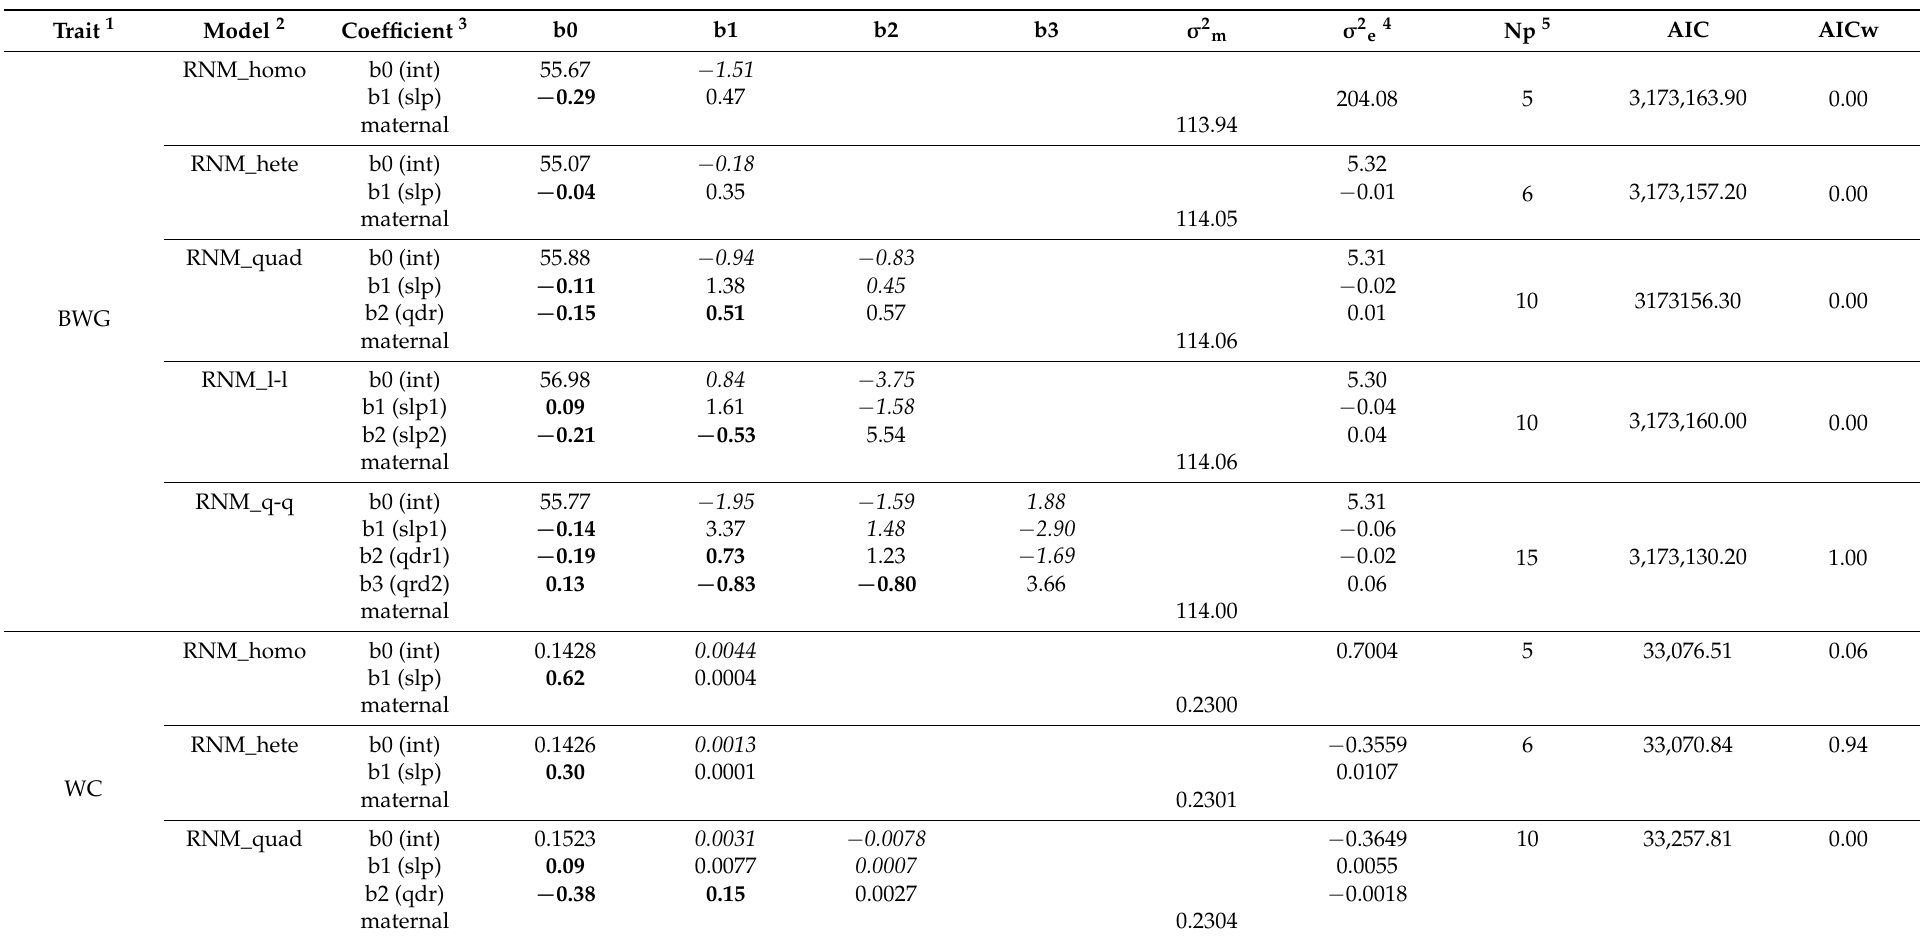
Table 3. Estimates of variance (diagonals), covariance (upper triangular; in italic), and correlation (lower triangular; in bold) among coefficients of reaction norm models (RNM) for the additive genetic effect of weaning traits in Nellore cattle, with respective residual variance estimates, Akaike information criterion (AIC), and AIC weight